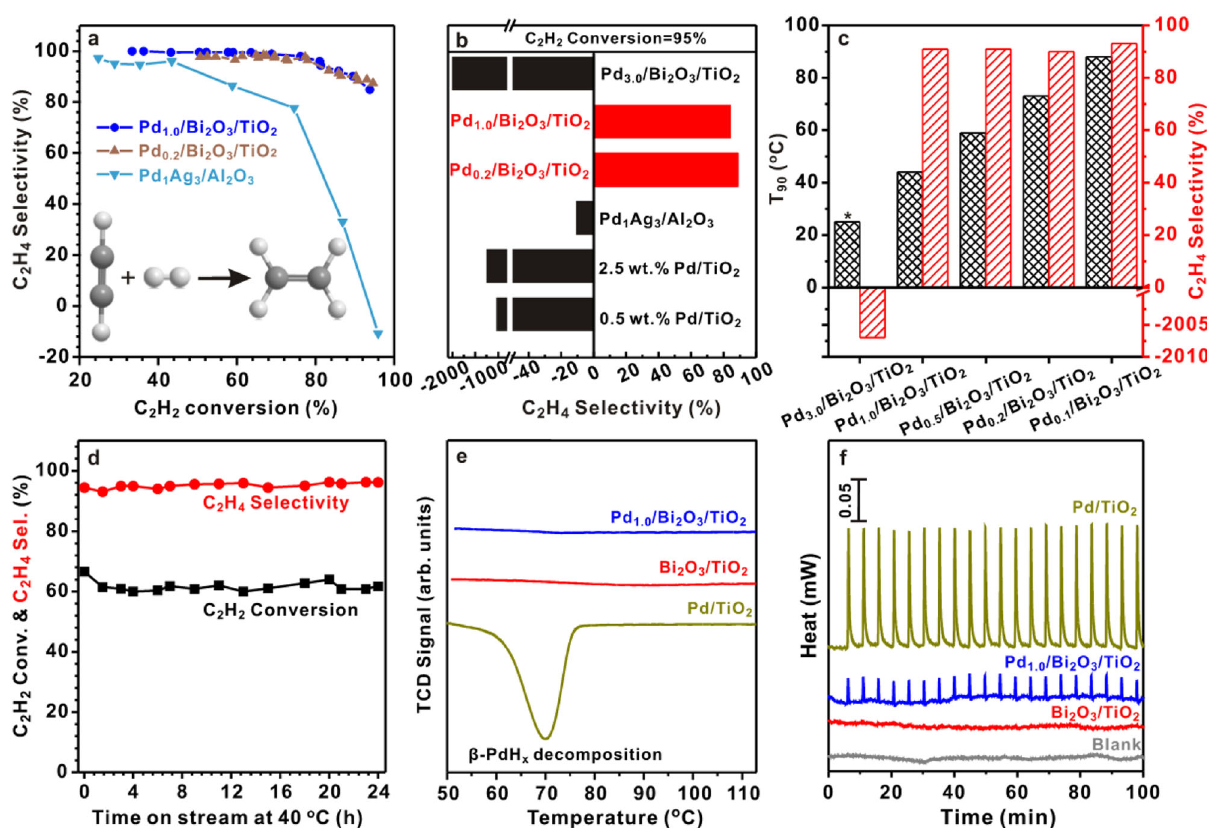
Fig. 3 Catalytic performances of Pd 1.0 /Bi 2 O 3 /TiO 2 in acetylene hydrogenation. a Selectivity as a function of acetylene conversion over Pd 1.0 /Bi 2 O 3 /TiO 2 , Pd 0.2 /Bi 2 O 3 /TiO 2 , and PdAg 3 /Al 2 O 3 . b The selectivity to C 2 H 4 for 95% acetylene conversion over different catalysts. c Reaction temperature ( T 90 ) and C 2 H 4 selectivity for 90% acetylene conversion. *For Pd 3.0 /Bi 2 O 3 /TiO 2 , hydrogen dissociation easily takes place at room temperature. The strong exothermic effect of unselective acetylene hydrogenation eventually leads to a runaway temperature up to 63.5 °C. d C 2 H 2 conversion and C 2 H 4 selectivity with time on stream over Pd 1.0 /Bi 2 O 3 /TiO 2 at 40 °C. e H 2 -TPR pro fi les for Pd/TiO 2 , Bi 2 O 3 /TiO 2 , and Pd 1.0 /Bi 2 O 3 /TiO 2 . f Microcalorimetric studies of C 2 H 4 pulse adsorption over Pd/TiO 2 and Pd 1.0 /Bi 2 O 3 /TiO 2 . Source data are provided in a Source data fi